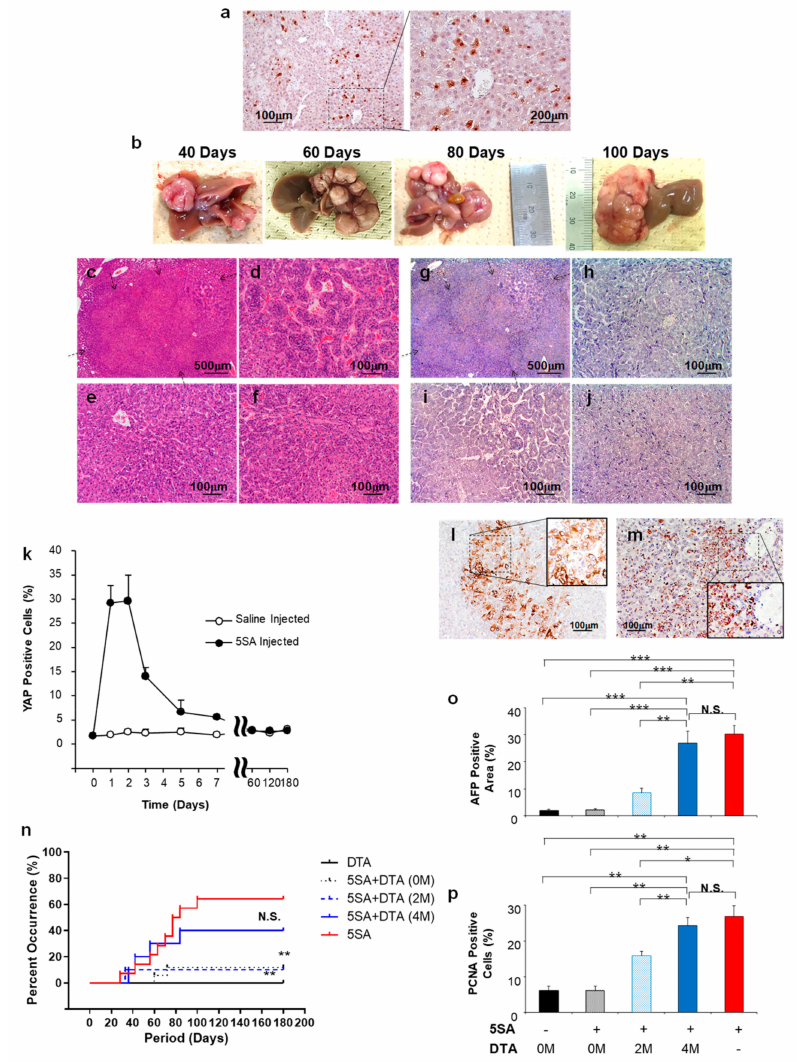
Figure 4. E ff ect of DTA on HCC mice model. ( a ) Expression of yes-associated protein (YAP) in the liver 3 days after the hydrodynamic gene delivery of YAP-expressing plasmid (5SA). ( b ) Representative images of time-dependent liver–tumor occurrence and sizes. ( c – f ) Hematoxylin and eosin staining and ( g – j ) immunohistochemical staining of YAP of the liver tumor. ( k ) Time dependent changes in YAP expression in the liver after 5SA injection. Quantification was performed by measuring the integrated density in pixels using the ImageJ software (version 1.6.0_20, National Institutes of Health, Bethesda, MD, USA). The values represent mean ± standard deviation ( n = 5 for each group). ( l , m ) Immunohistochemical staining of the AFP of the liver–tumor developed 40 ( l ) and 100 days ( m )